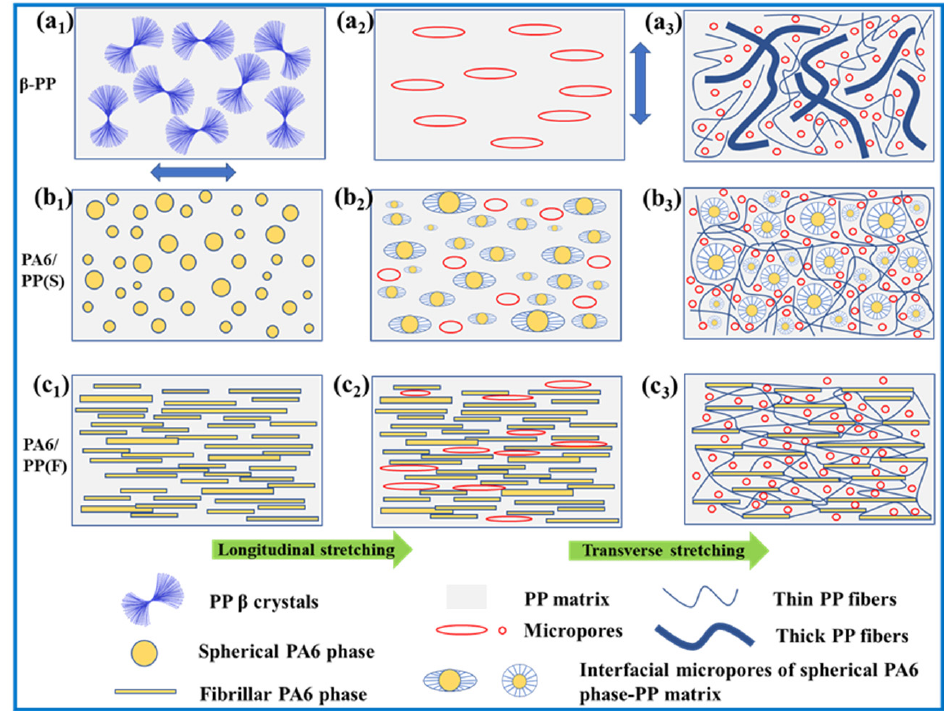
Figure 16. The schematic diagram of the micropore-forming mechanisms of ( a ) β -PP, ( b ) PA6/PP(S), and ( c ) PA6/PP(F) during sequential biaxial stretching. The blue double-headed arrow indicates the stretching direction. And ( a1 , b1 , c1 ) indicate the structure of unstretched films; ( a2 , b2 , c2 ) indicate the structure of longitudinally stretched membranes (200%); ( a3 , b3 , c3 ) indicate the structure of biaxially stretched membranes (200% × 200%).